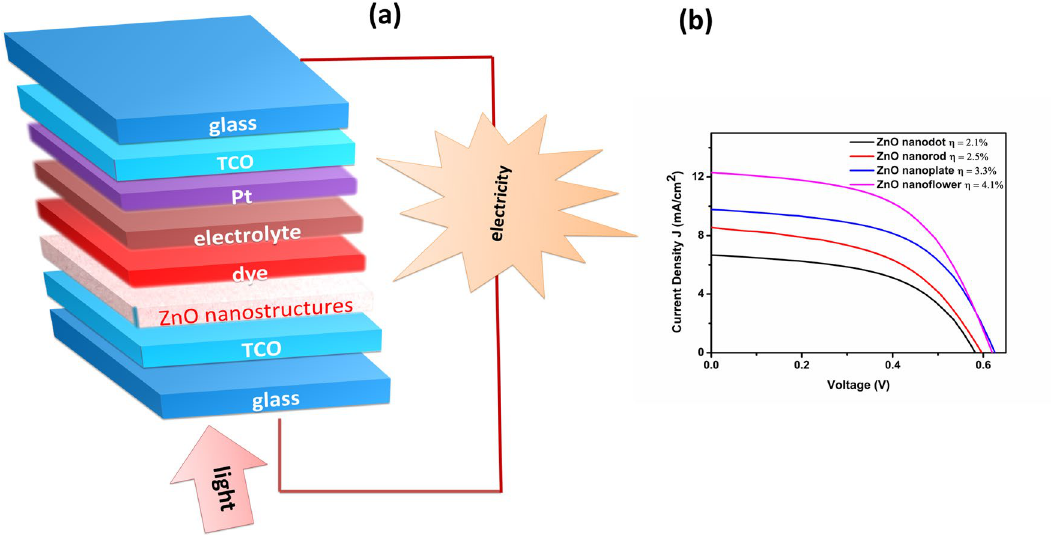
Figure 9. ( a ) Schematic representation of DSSC and ( b ) J–V curves of fabricated DSSCs usingZnO nanostructures as photoanode.